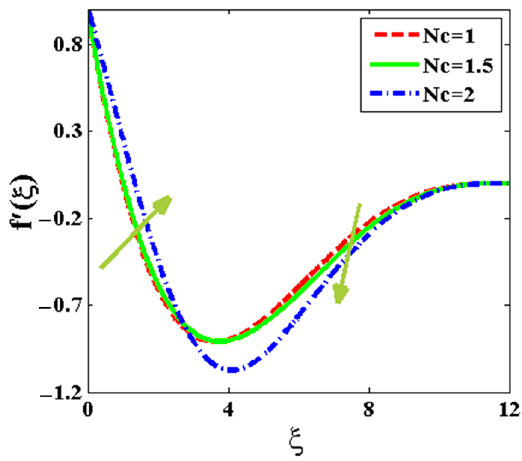
Figure 9. Outlines of 𝑓 ′ at diverse quantities of 𝑁𝑐 .